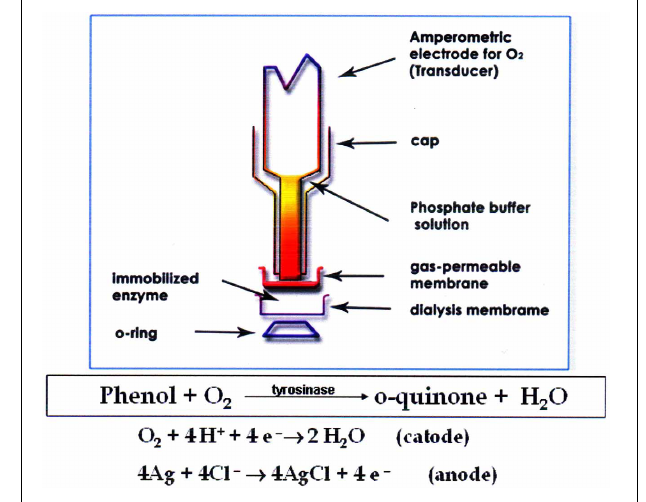
FIGURE 1 | Tyrosinase enzyme